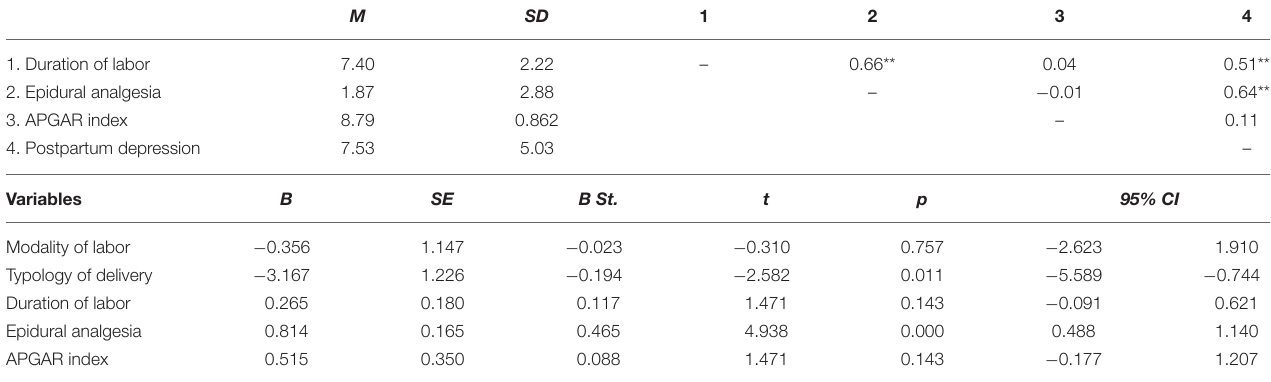
TABLE 4 | Descriptive statistics, correlations and summary of the linear regression analysis with the delivery characteristics as independent variables for PPD